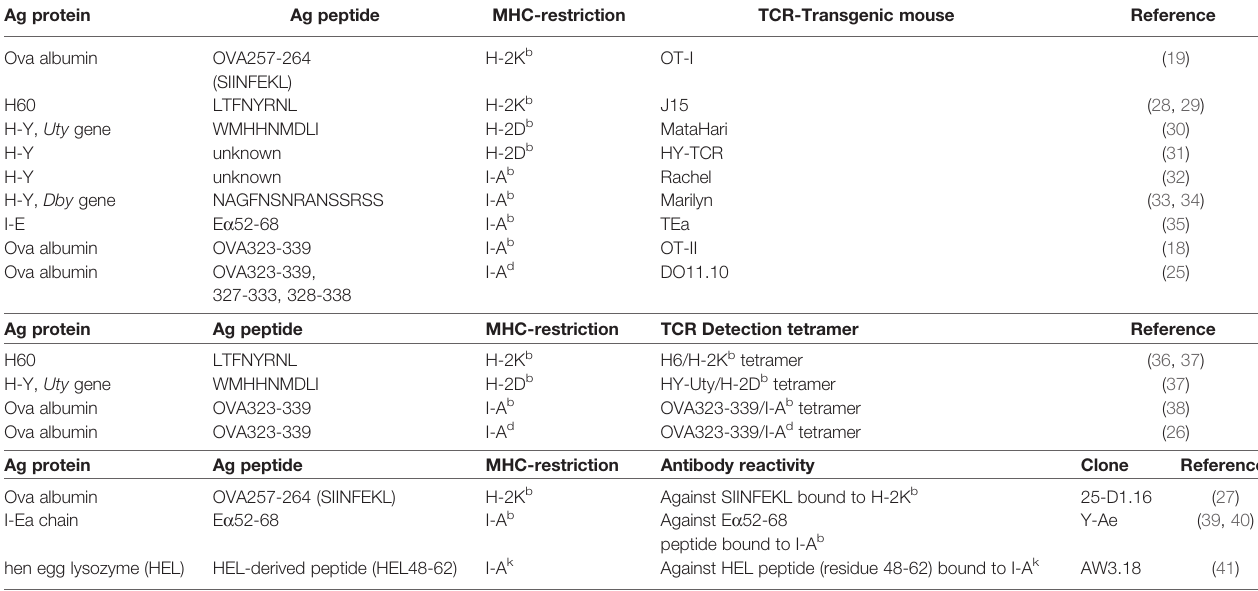
TABLE 1 | Minor antigens within MHC matched systems and antigen-speci fi c TCR transgenic T cells (top), peptide-MHC tetramer to detect antigen-speci fi c T cells (middle) and antibodies to quantify antigen-MHC complexes (bottom). Ag